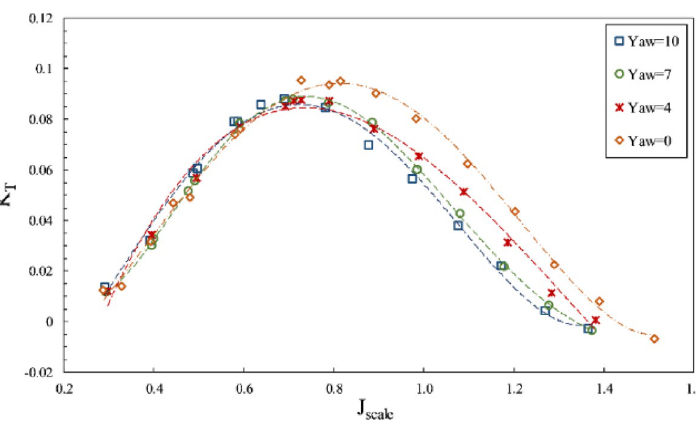
Figure 27. The effect of yaw angle on the thrust coefficient in the propeller direction ( I = 0.4